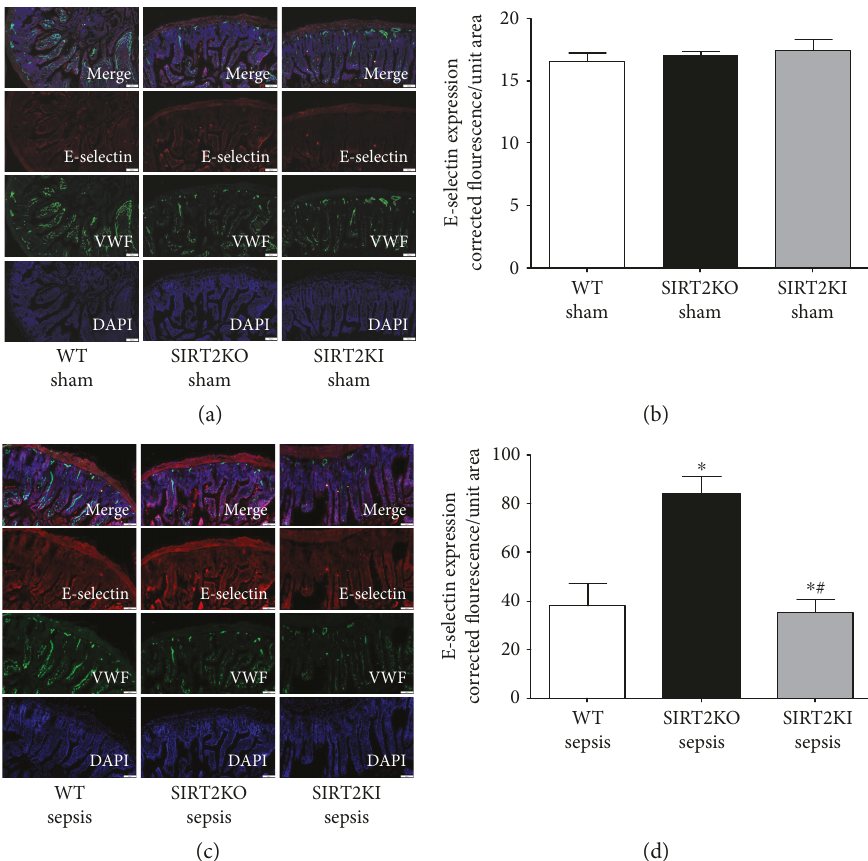
Figure 3: E-selectin expression in WT, SIRT2KO, and SIRT2KI mice. We stained small intestinal tissue for E-selectin expression E-selectin (Cy3: red), Von Willebrand factor (VWF, FITC: green), and nuclear stain (DAPI: blue). (a) shows representative images of E-selectin expression in WT, SIRT2KO, and SIRT2KI mice with sham surgery while (b) shows fl uorescence quanti fi cation of immunohistochemistry of three di ff erent mice in each group. There was no signi fi cant di ff erence in E-selectin expression of WT, SIRT2KO, and SIRT2KI mice with sham surgery from each other. As shown in (c) (representative images) and (d) ( fl uorescence quanti fi cation from immunohistochemistry; n = 3 in each group), the E-selectin expression increased in SIRT2KO sepsis mice versus that in WT sepsis mice while it was decreased in SIRT2KI sepsis mice versus that in SIRT2KO sepsis mice. ∗ p < 0 05 versus that in WT sepsis group; # p < 0 05 versus that in SIRT2KO sepsis group; using Tukey ’ s post hoc analysis; error bars: